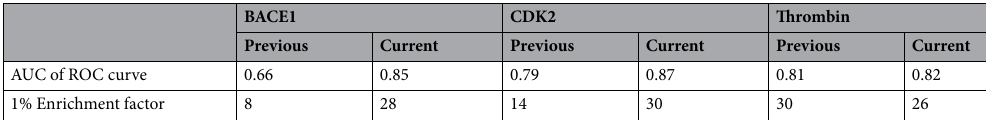
Table 1. Enrichment of actives over decoys by docking in previous 30 and current study of these target/ compound sets, as measured by the Area Under Curve (AUC) of the ROC curve (Receiver Operating Characteristic curve) and the enrichment factor of the top scoring 1% compounds. Note that these statistics are computed for the full set of ∼ 20, 000 compounds per target, while those in Fig. 1 are for the Tier 1 and Tier 2 subsets.